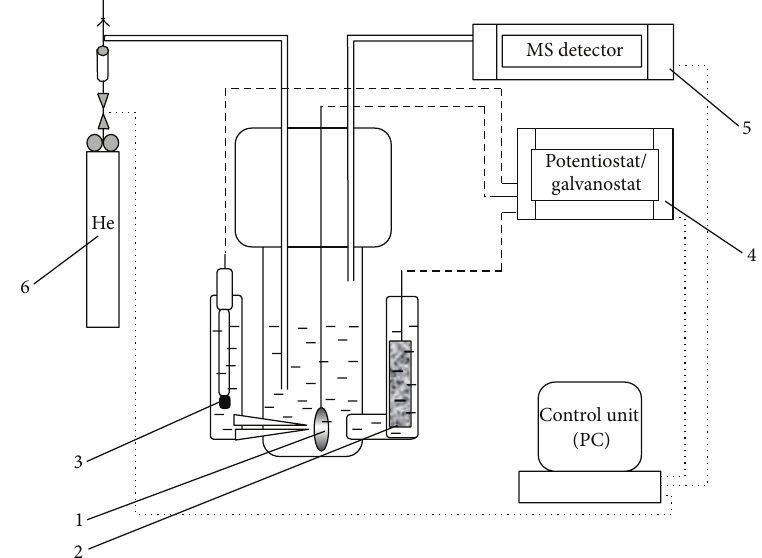
Figure 1: Experimental setup: (1) working electrode, (2) counterelectrode, (3) reference electrode, (4) potentiostat/galvanostat, (5) MS detector, and (6)